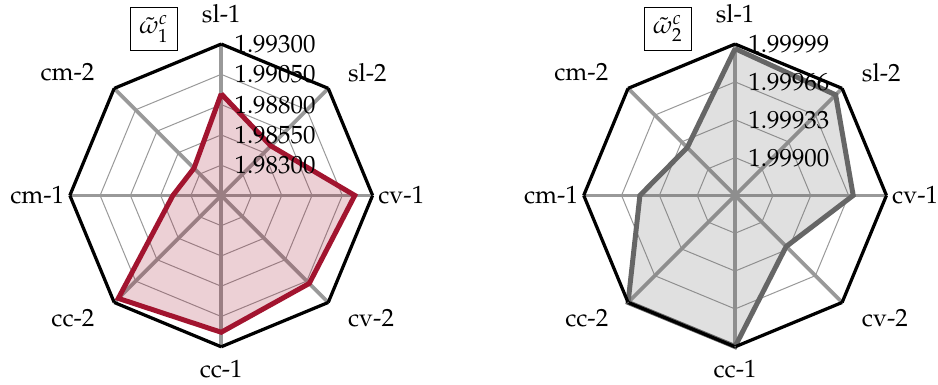
Figure 14. MRT accuracy and stability range comparison for different grid